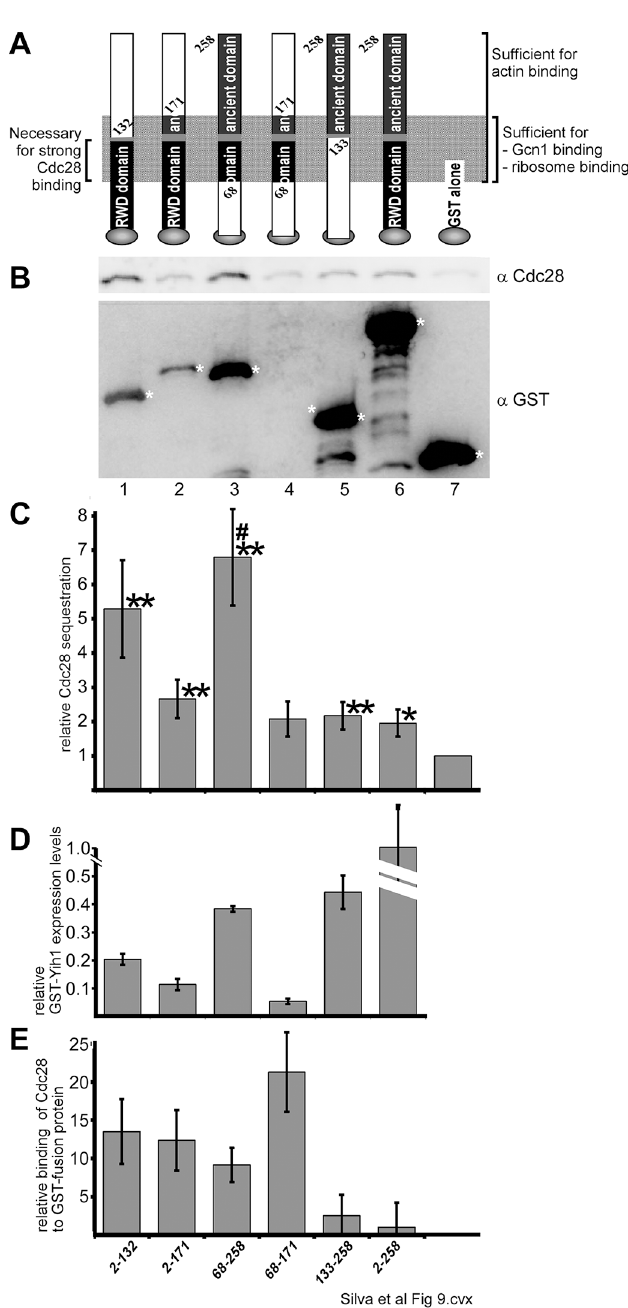
Fig 9. Cdc28 binding to Yih1 fragments. (A) Schematics of the GST-tagged Yih1 fragments used in this study. The N-terminal RWD domain and the C-terminal ancient domain are indicated, as well as the Yih1 region sufficient for actin, Gcn1, and ribosome binding (modified from [3] ) . On the left, the Yih1 region encompassing the major Cdc28 binding determinant, as found in this study is shown. The schematic is not to scale. (B) Identical amounts of total protein from WCEs of the gcn1 Δ strain H2556 overexpressing the indicated GST-tagged Yih1 fragments, were subjected to GST-mediated pull-down assays as described earlier [3]. The precipitated material was subjected to SDS-PAGE and immunoblot using antibodies against Cdc28 and GST. The assay was conducted at least six times, and a representative result is shown. * indicates the location of the respective GST-fusion protein in the blot. (C) The amount of Cdc28 sequestered in B was determined by quantifying the signal intensity of the Cdc28 signals from at least six independent results, using the NIH Image J software. The values are shown relative to those found for whole cell extracts containing GST alone. (D) The overexpression levels of the Yih1 fragments are shown relative to